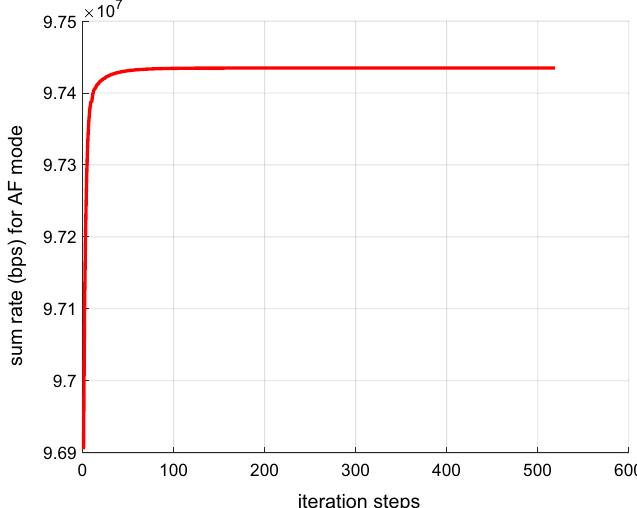
Fig. 5 Convergence curves in AF mode. It is the sum-rate convergence curves curve when the relay nodes are 8 and the transmit SNR is 25 db in AF